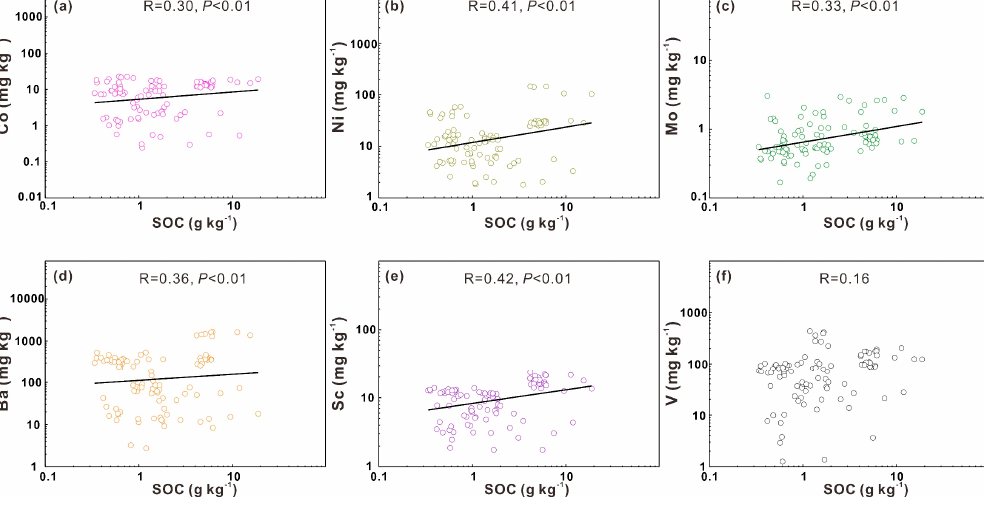
Figure 5. Linear correlation between soil organic carbon (SOC) and the heavy metals Co ( a ), Ni ( b ), Mo ( c ), Ba ( d ), Sc ( e ), V ( f ).